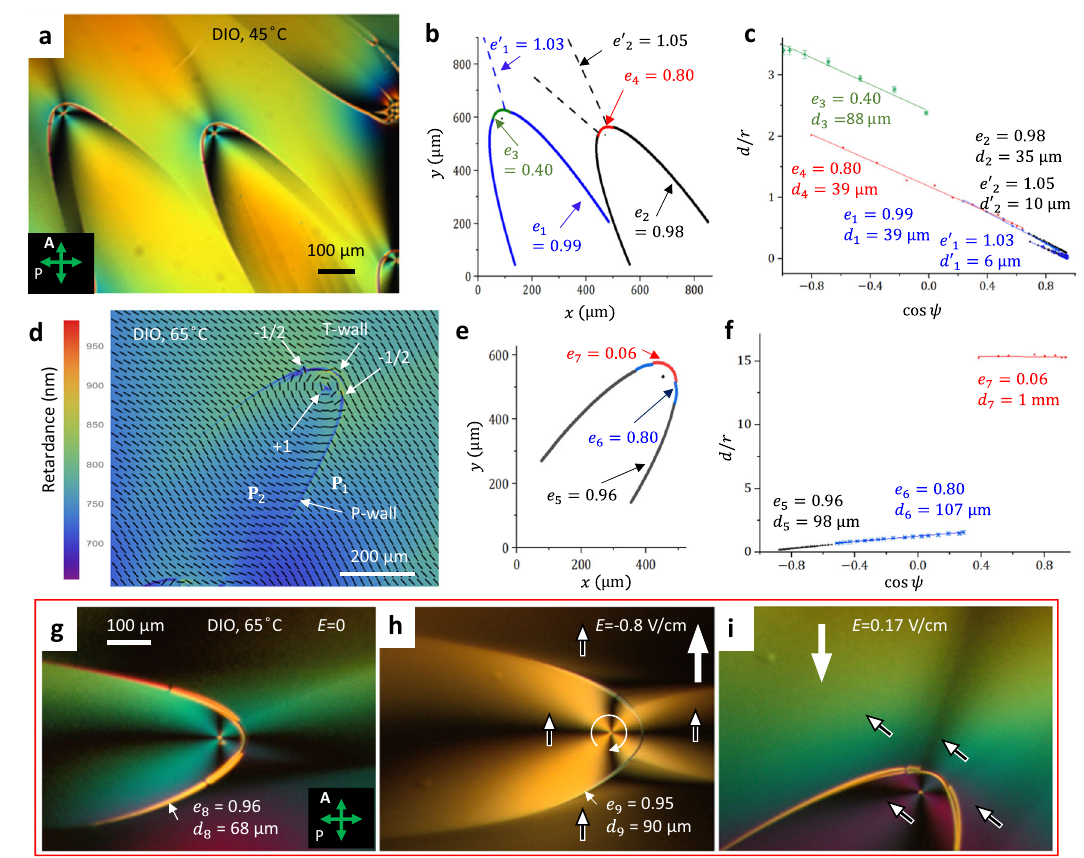
Fig.1|ParabolicdomainwallsinN F fi lmsofDIO.a Polarizingmicroscopytexture oftwoP-wallswithfociatthecoresofcircular+1vortices;theaverage fi lmthickness h ≈ 4.8 μ m; note two “ ghost ” parabolas extending to the upper left corner. b The corresponding eccentricities e . c The corresponding eccentricities e and distances d to directrices as fi ts to Eq. (1). d PolScope Microimager texture of a P-wall separatingavortex P 2 fromanearlyuniform P 1 ;thetipoftheP-wallisreplacedbya T-wall, ending at two − 1/2 disclinations; the yellow pseudo color of the T-wall is an